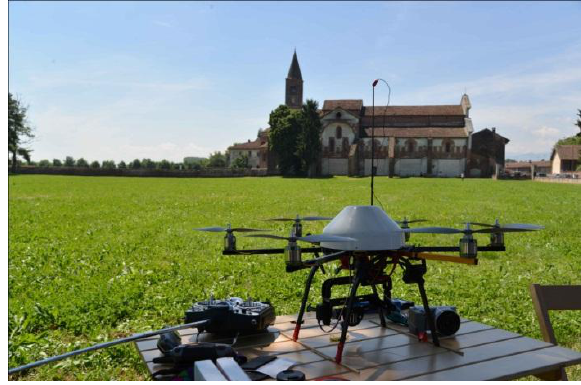
Figure 6. North front processed from laser scanner data